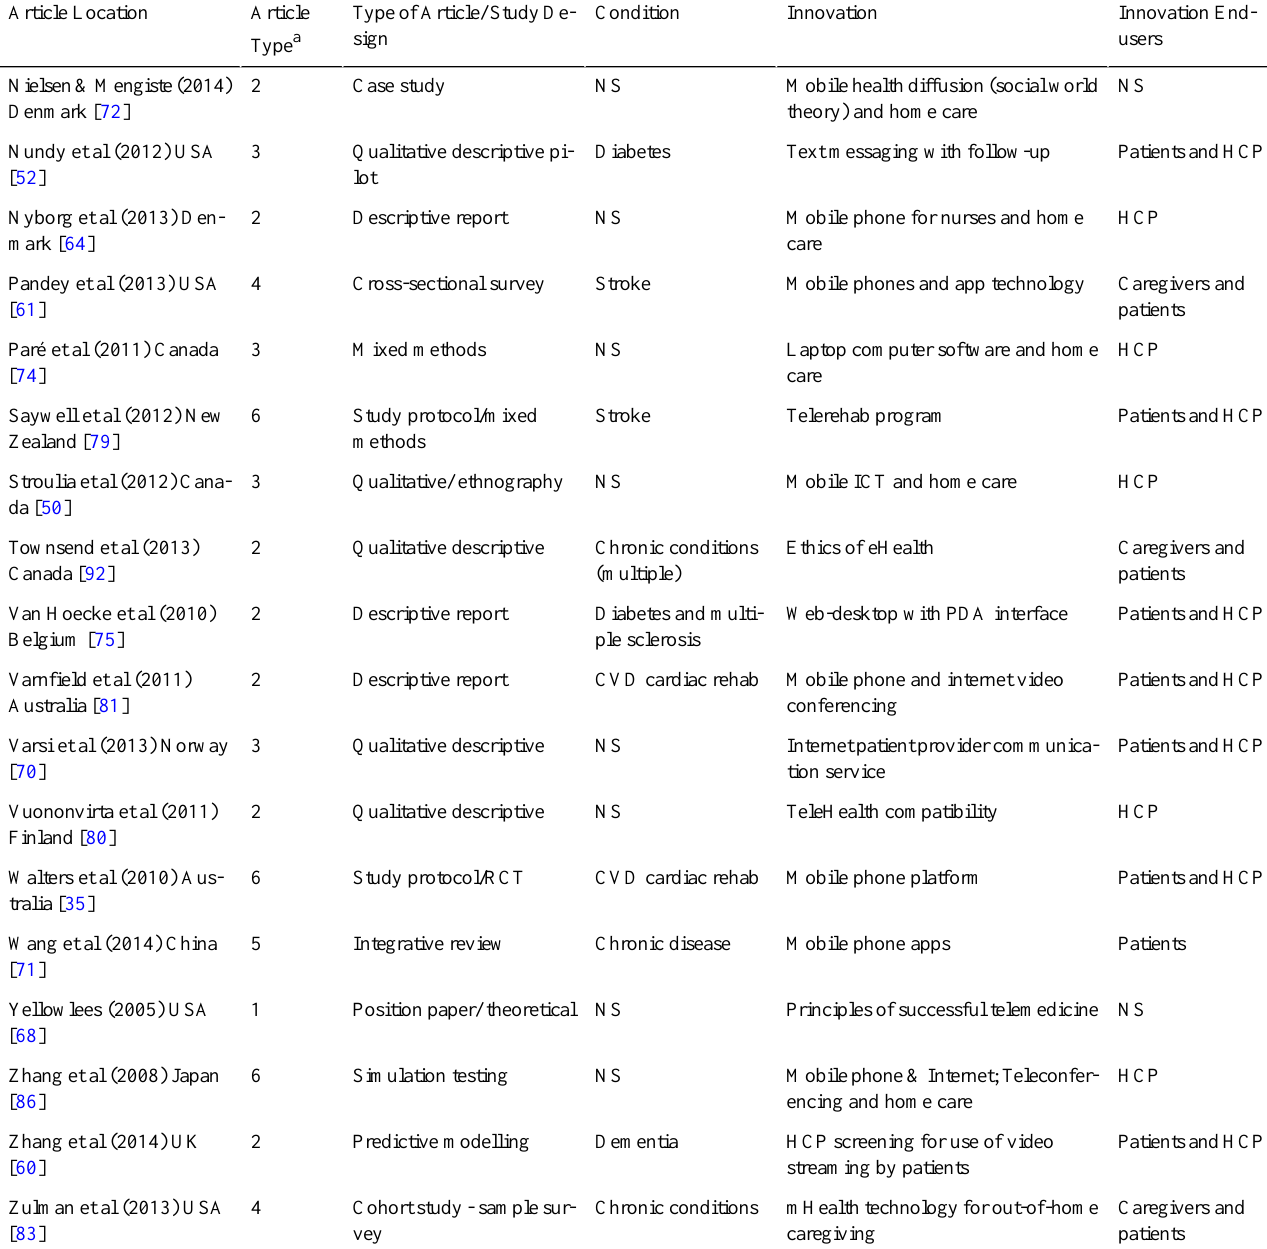
f CVD: cardiovascular disease g COPD: chronic obstructive pulmonary